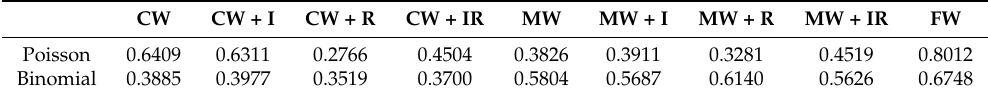
Table 6. Kullback–Leibler